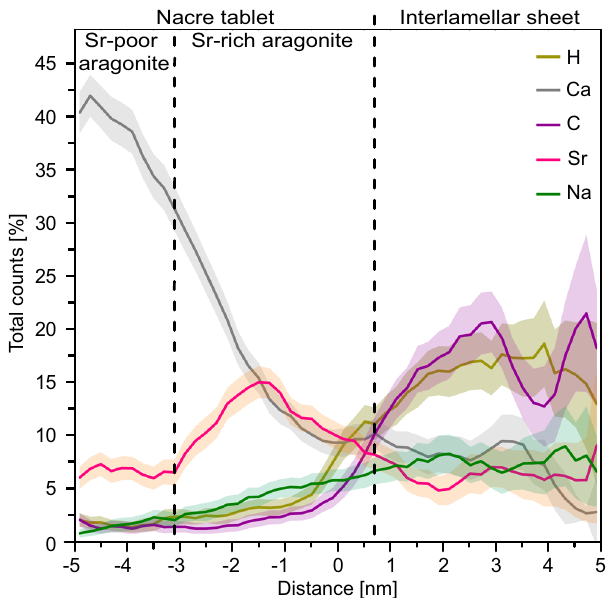
Fig.4|Compositionalpro fi lethroughtheAPTreconstructionacrossthenacre tablet. The qualitative pro fi le across the APT reconstruction shown in Fig. 3. The plot is divided by black dashed lines into three sections: Sr-poor aragonite, Sr-rich aragonite and interlamellar sheet. The transition from Sr-poor to Sr-rich aragonite is de fi ned by a signi fi cant increase in Sr, while the transition from Sr-richaragonite totheorganicinterlamellarsheetisde fi nedasthepointofintersectionbetweenthe Ca (grey) and the C (magenta) signals (see methods). The Sr-poor aragonite is characterisedbyhighCaconcentrationsindicativeof CaCO 3 ,whilethe Sr-richarea is de fi nedby high Sr(red)atintermediate Ca and the interlamellar sheet by high C andH(yellow)counts.TheSr-enrichedareaappearswithin4nmofthemineralised nacre tablet adjacent to the organic sheet. The abundance of Na (green) increases steadily from the tablet into the organic sheet. Shaded envelopes depict the fi rst standard